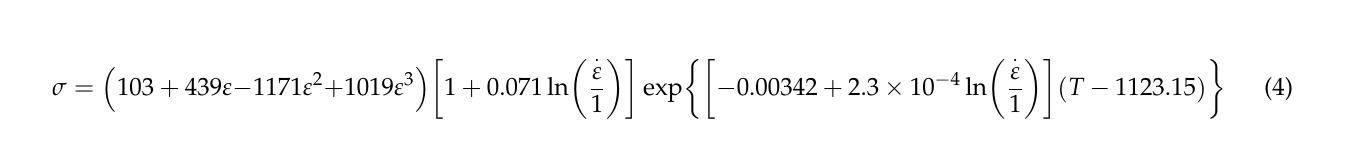
Table 1. Parameters of the modified JC model at reference condition of 850 ◦ C and 1 s − 1